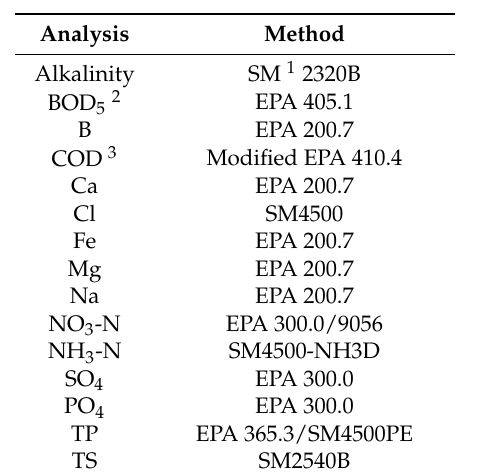
Table 2. Analytical methods used for water quality